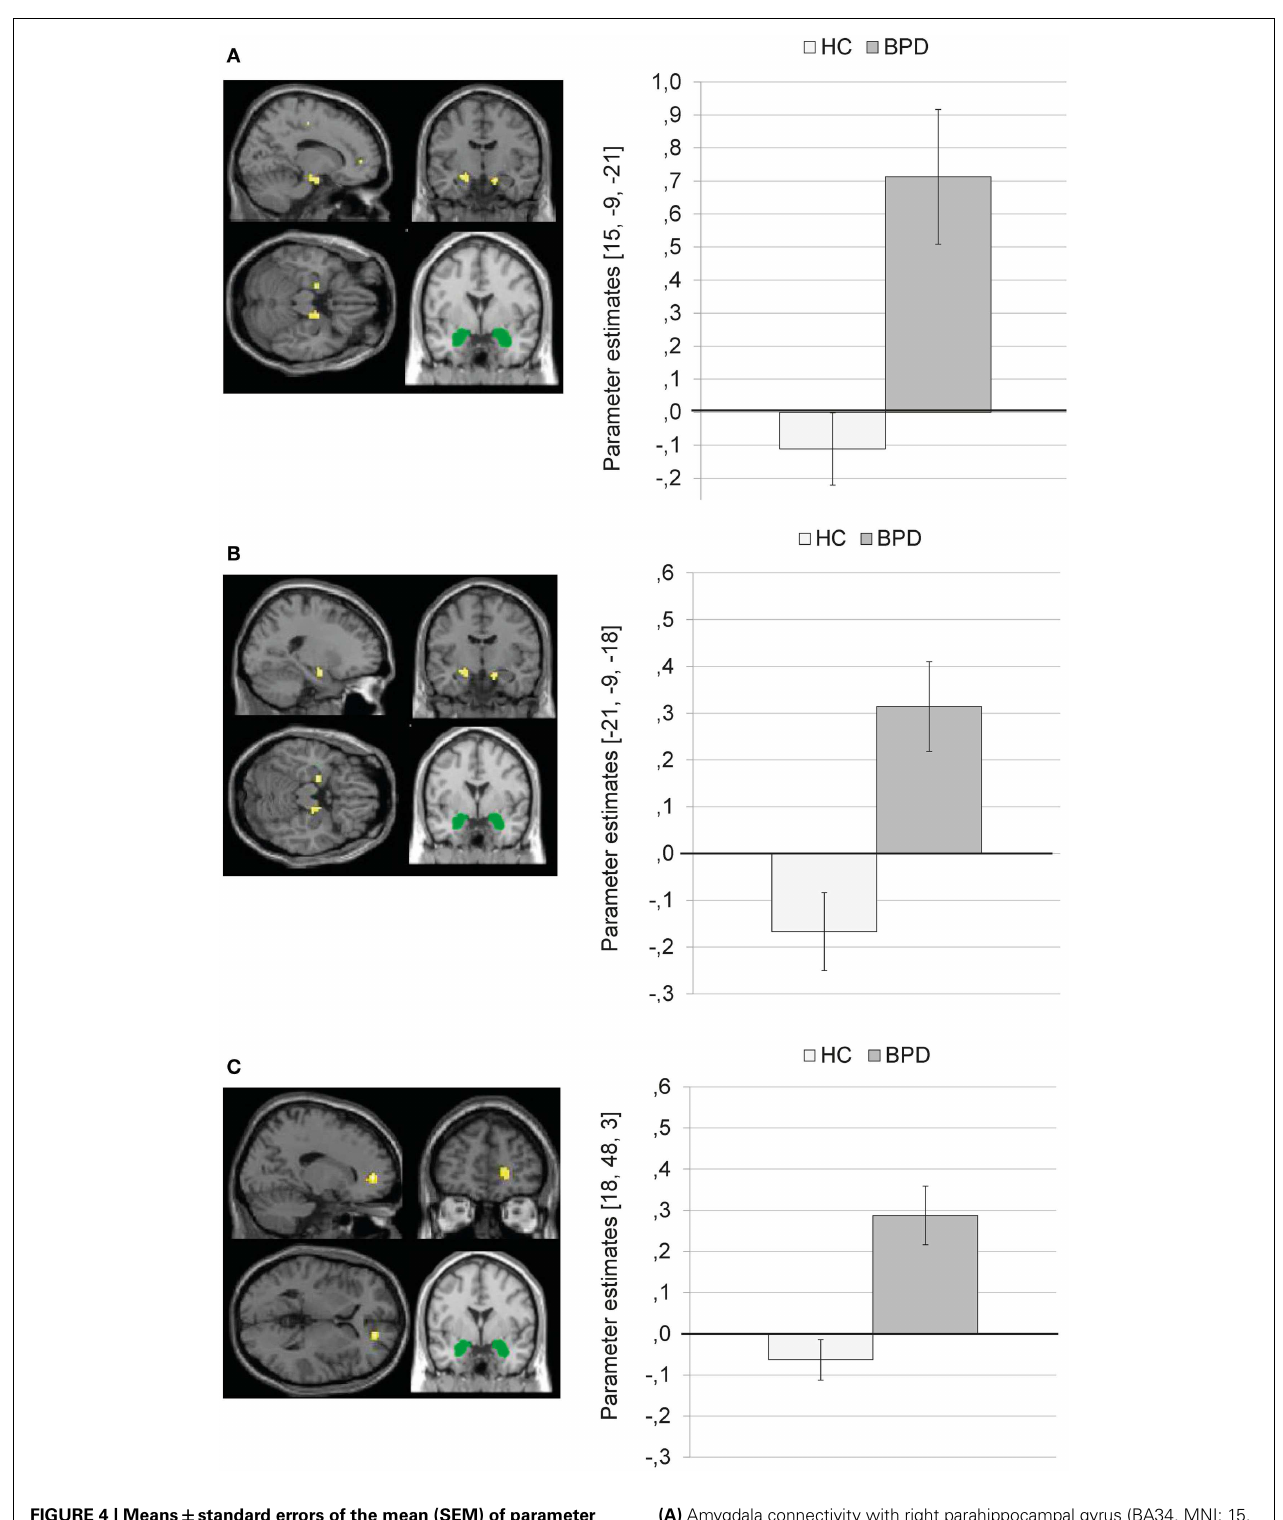
FIGURE 4 | Means ± standard errors of the mean (SEM) of parameter estimates for stronger connectivity of the bilateral amygdala seed (depicted in green) in borderline personality disorder (BPD) than in healthy controls (HC) during presentation of negative distractors .